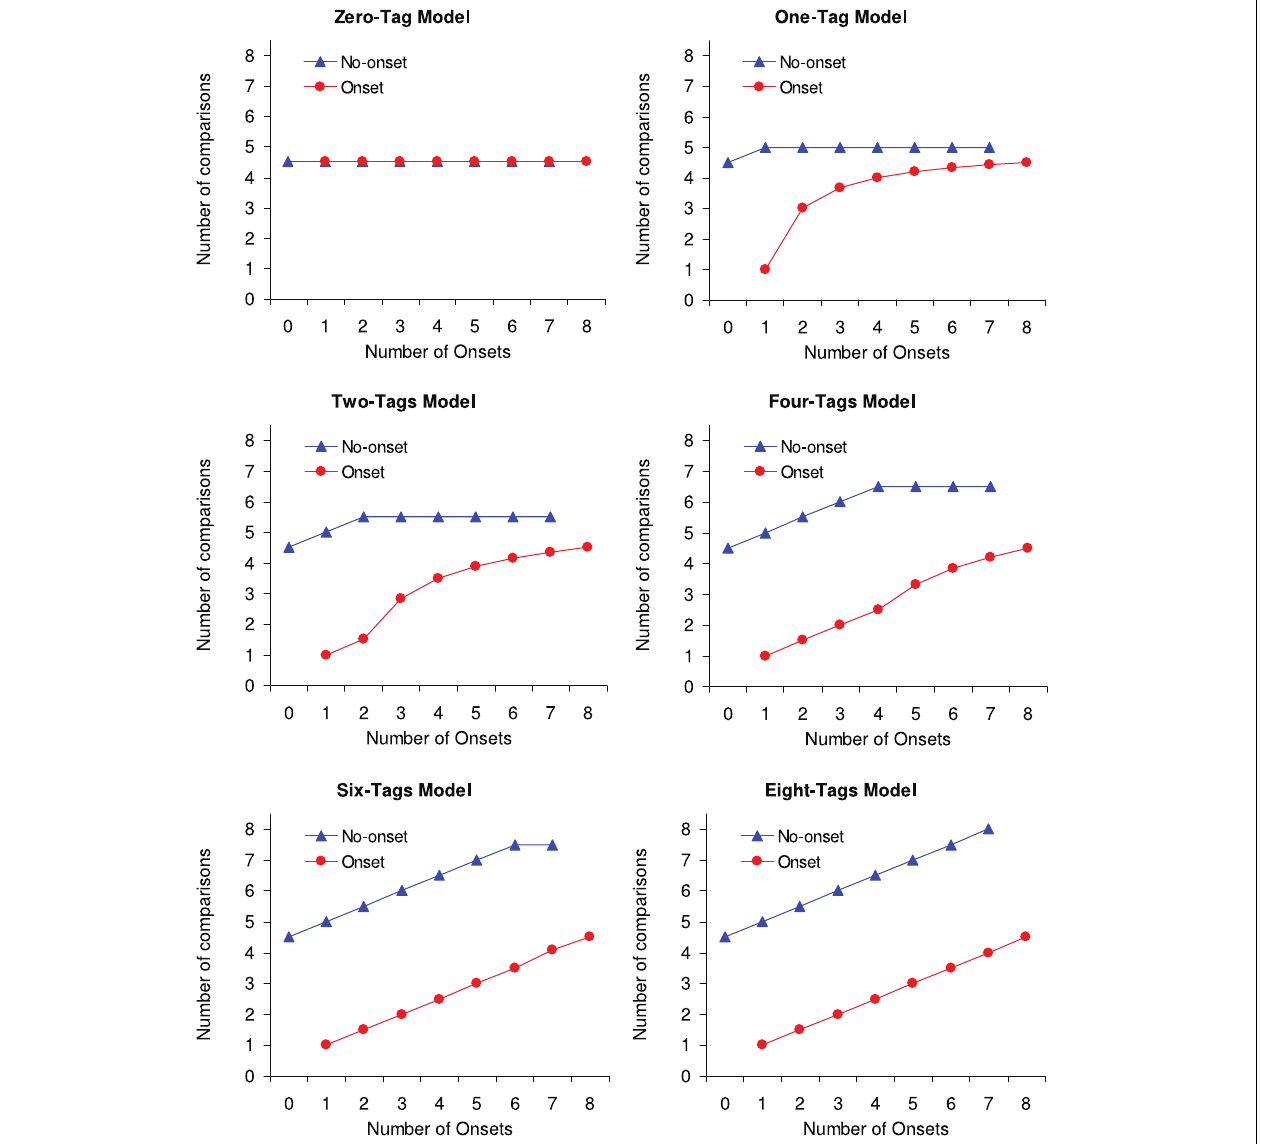
FIGURE 1 | Expected number of comparisons y as a function of number of onsets x with separate lines for onset and no-onset targets. Each graph represents a different capacity c .